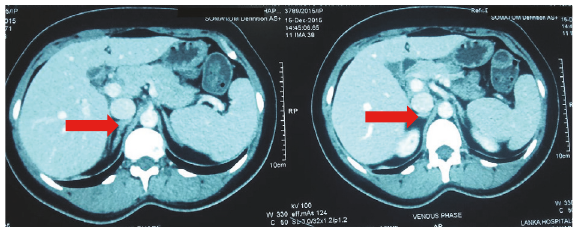
Figure 1: Contrast enhanced CT abdomen showing right-sided adrenal adenoma (red